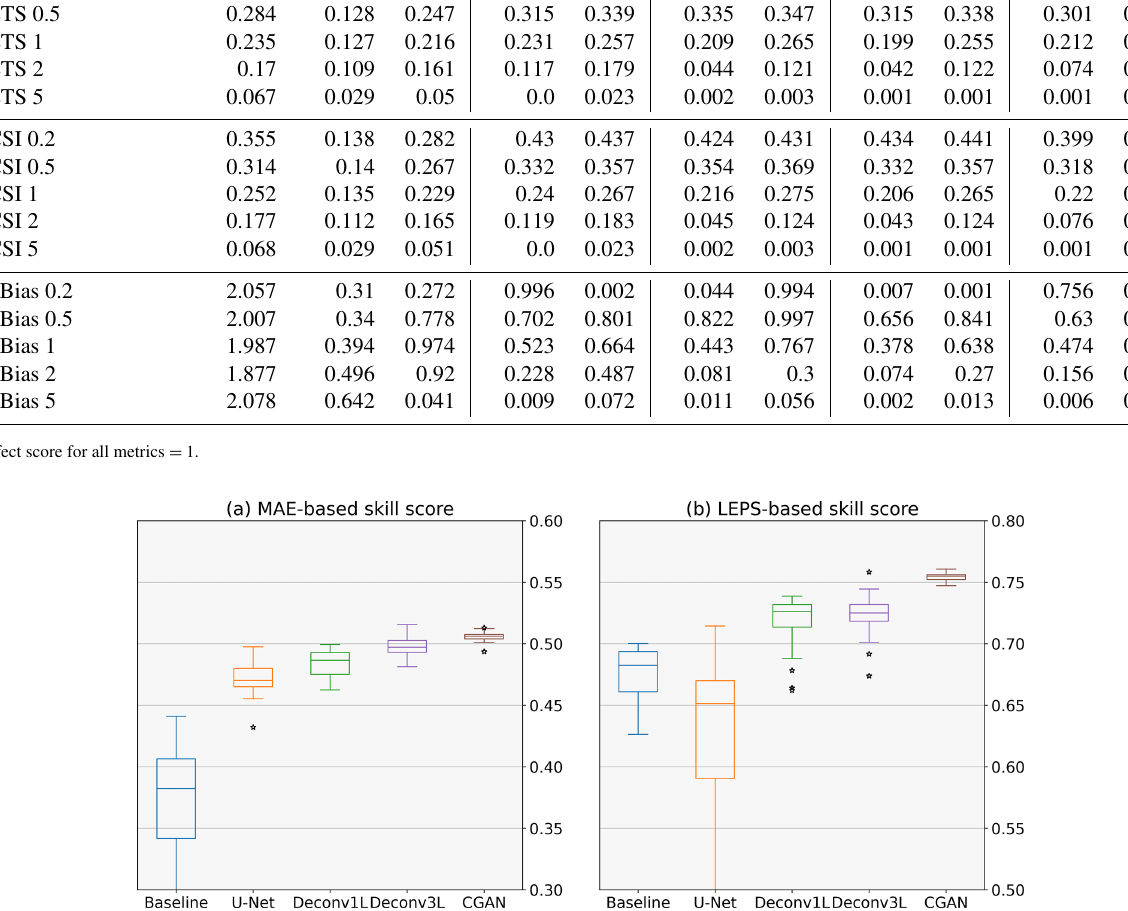
Figure 4. Quantitative metrics: each subplot compares the skill score of the different models. In panel (a) , each boxplot illustrates the MAE- based skill score, and in panel (b) , the LEPS-based skill score of 20 runs for each model with different initializations is depicted. The higher the skill score, the higher the improvement over the reference (in this case, COSMO-DE-EPS). A skill score of 0 represents no improvement, and a negative skill score indicates decay in the